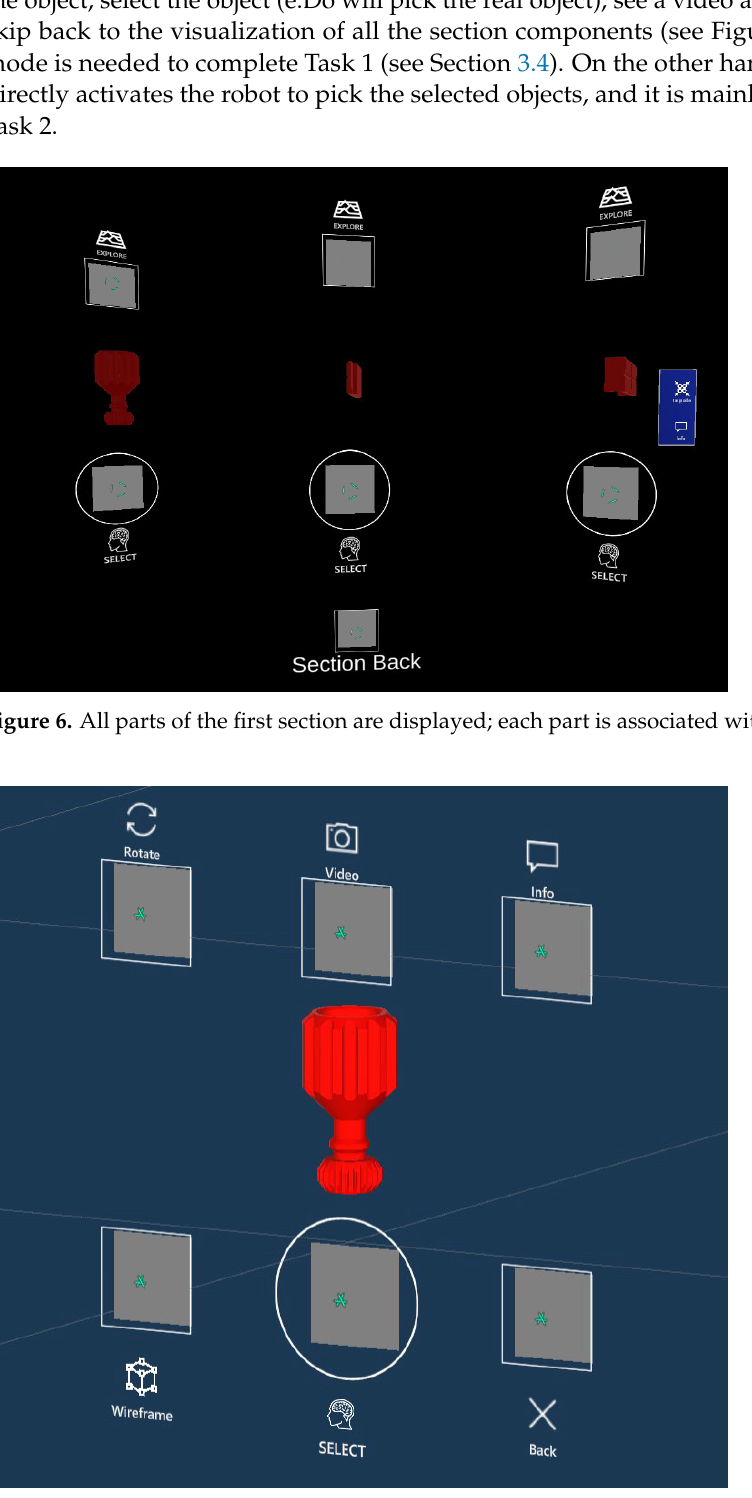
Figure 7. In Explore mode, the user can achieve more information about the selected